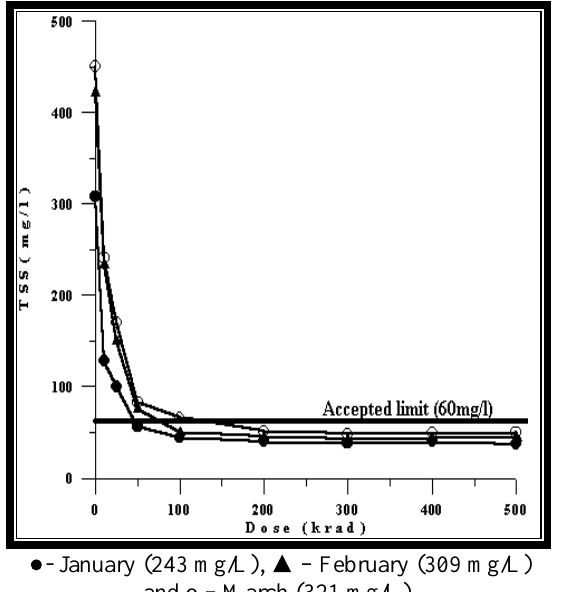
Figure 6: BOD wastewater for BOD